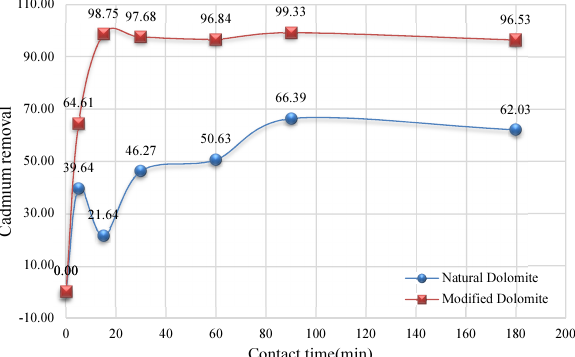
Contact time(min) Fig. 2. Comparison of removal efficiency of cadmium (%) from solution (5 mg/l) by natural dolomite and modified dolomite (1 g) within specified contact times